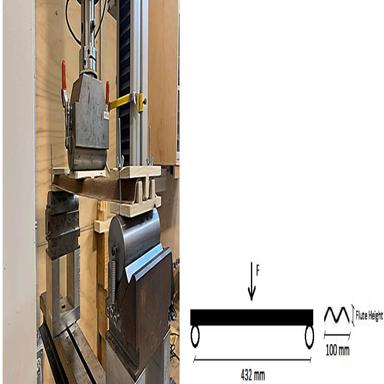
Longitudinal bending test on corrugated panel with use of anti-crushing devices.